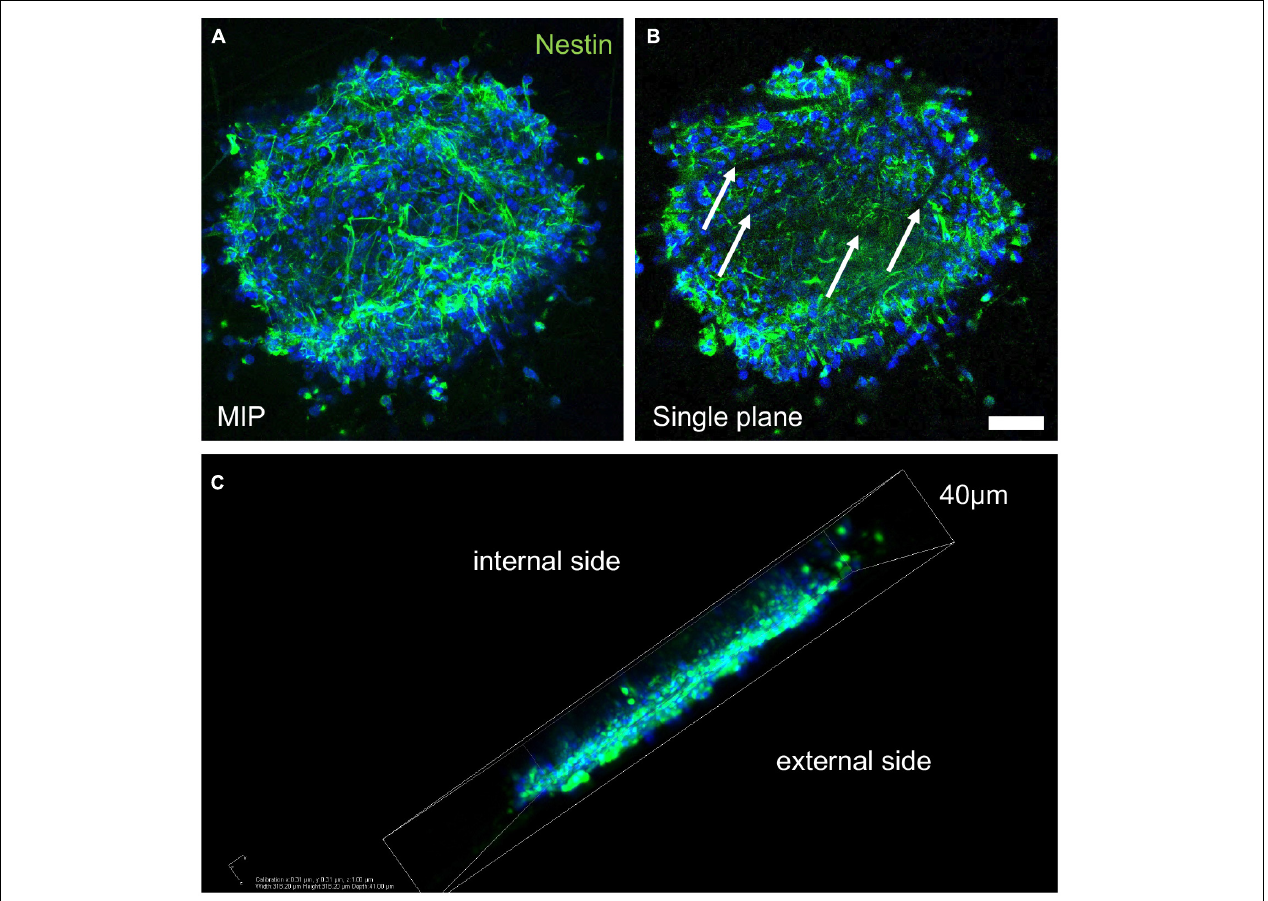
FIGURE 2 | Sphere integration into the three-dimensional PBT scaffold. (A–C) Representative images of confocal z-stack derived maximum intensity projection (MIP; A ), single plane picture (B) , and 3D reconstruction (C) of a secondary neurosphere seeded in VITVO and stained by immunocytochemistry for nestin marker, after 3 days in culture. White arrows in B indicate the PBT fibers. Scale bar (A,B) 30 µ